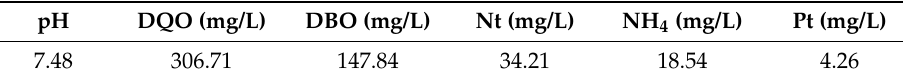
Table 1. Waste water